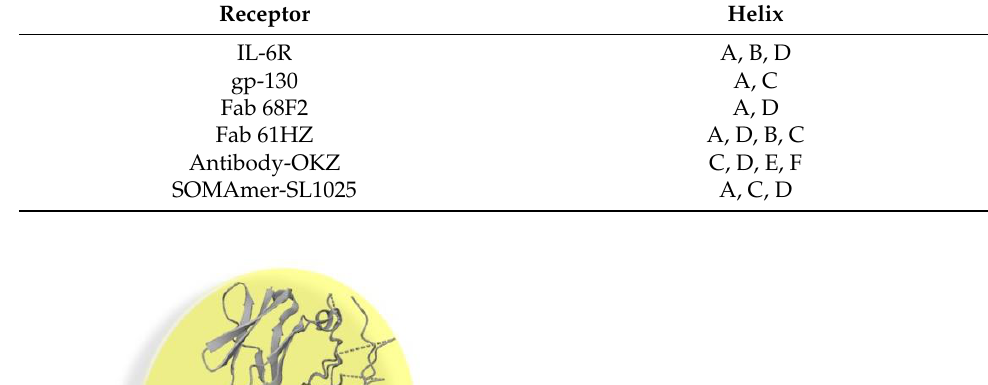
Table 3. List of IL-6 analyzed receptors. For each receptor, the IL-6 helices mainly involved in the binding process are reported, see Figure 2. Figure 2. Contact maps of cytokine IL-6 complexed with different receptors. In all figures, cytokine IL-6 is drawn in blue and interlinks are in black. ( a ) the natural assembly gp-130*IL-6*IL-6R. Protein gp-130, i.e., receptor β , is drawn in green, protein IL-6R, i.e., receptor α , is drawn in indigo. The links between the receptors and the cytokine are drawn in black. The sequence of residues is reported on the axes, normal style for receptor β , bold for cytokine, slanted for receptor α ( b ) the assembly with humanized Fab 61H7 (in red); ( c ) the assembly with SOMAmer SL1025 (in red); ( d ) the assembly with olokizumab (in red). The cut-off value is 15 Å . Capital letters emphasize the main contacts with the cytokine helices, specifically, with helix A (SER21-SER47), helix B (GLU80-ARG104), C (SER107-